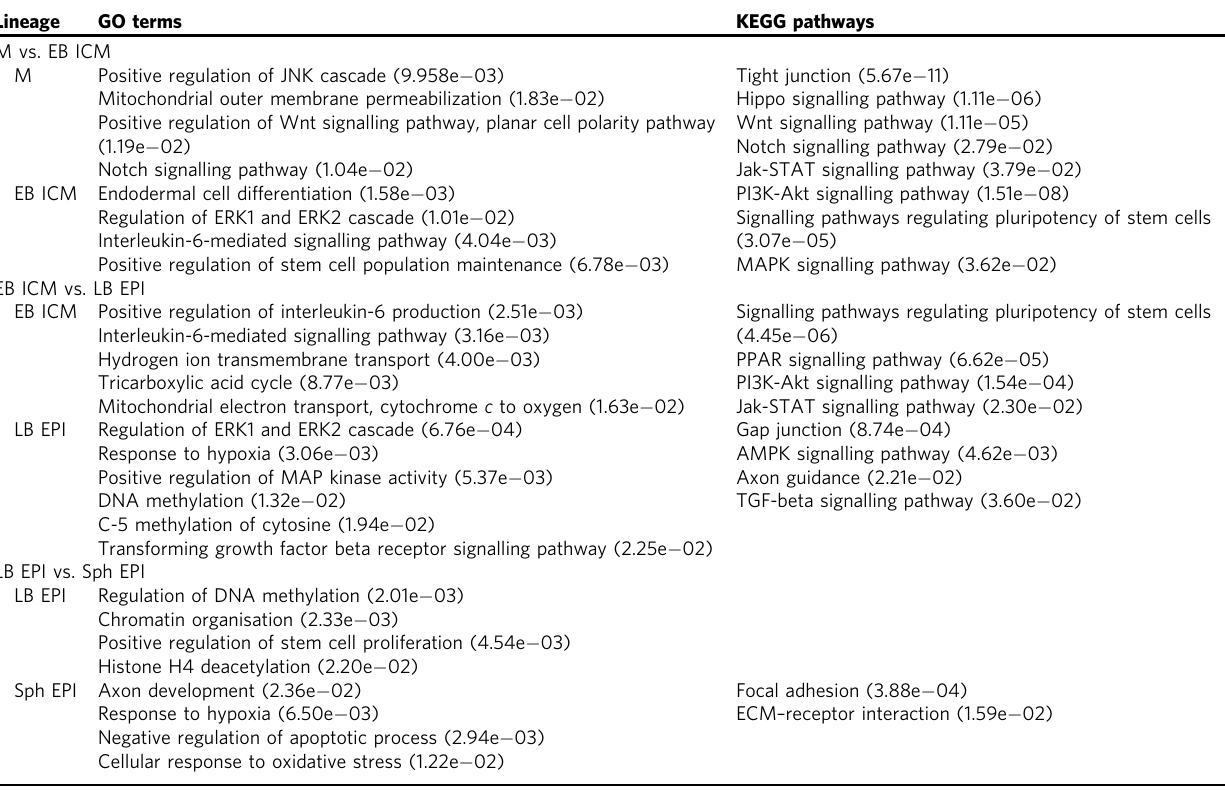
Table 4 Gene ontology and KEGG pathways determined by pairwise comparisons of pluripotent cells of the pig embryo